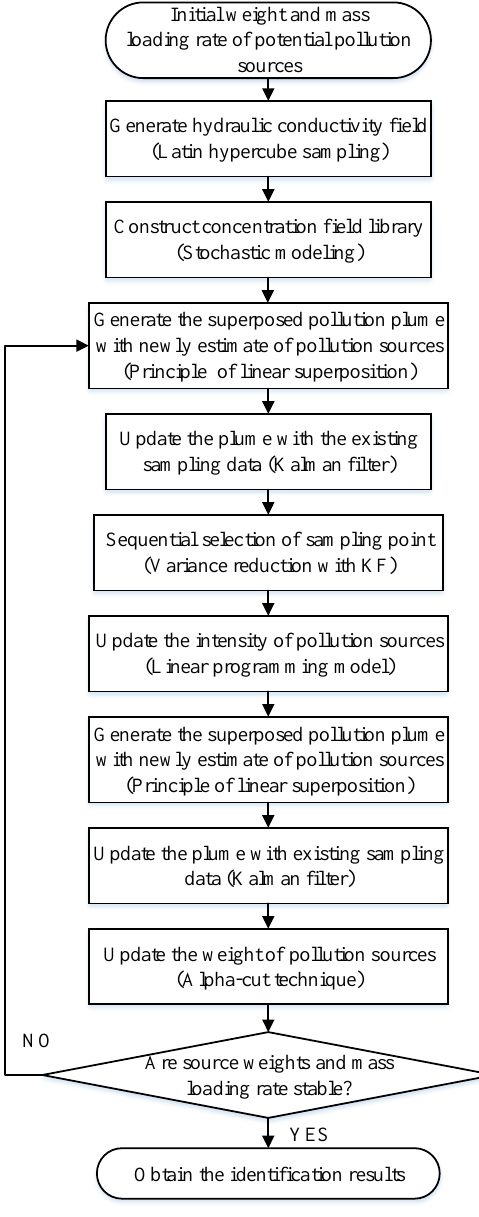
Figure 1. Flow diagram of the pollution source identification using the proposed Kalman filter-based method.